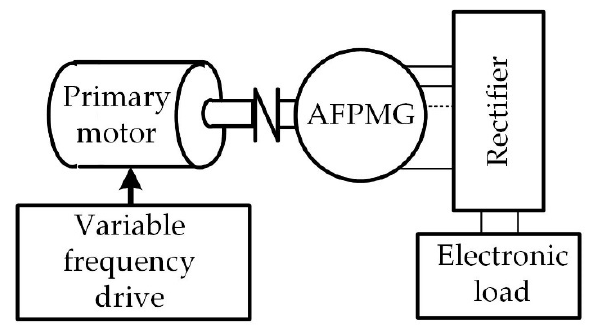
Figure 10. Schematic diagram of the experimental setup.